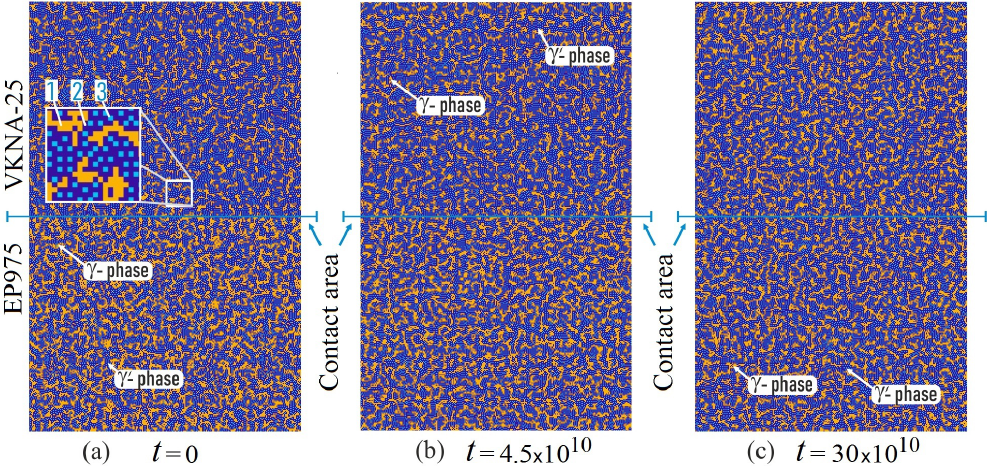
Figure 3. Structure evolution during diffusion bonding of EP975 and VKNA-25 alloys. ( a ) Initial structure with the lower (upper) half occupied by the EP975 (VKNA-25) alloy. Inset shows the structure at the atomic scale. Ni, Al and Cr are shown by dark blue, light blue and yellow colors. Ni and Al create Ni 3 Al intermetallide and Cr is dissolved in it creating small clusters. ( b , c ) Structure at t = 4.5 × 10 10 and 3.0 × 10 11 , respectively. The number of vacancy jumps is used as the measure of